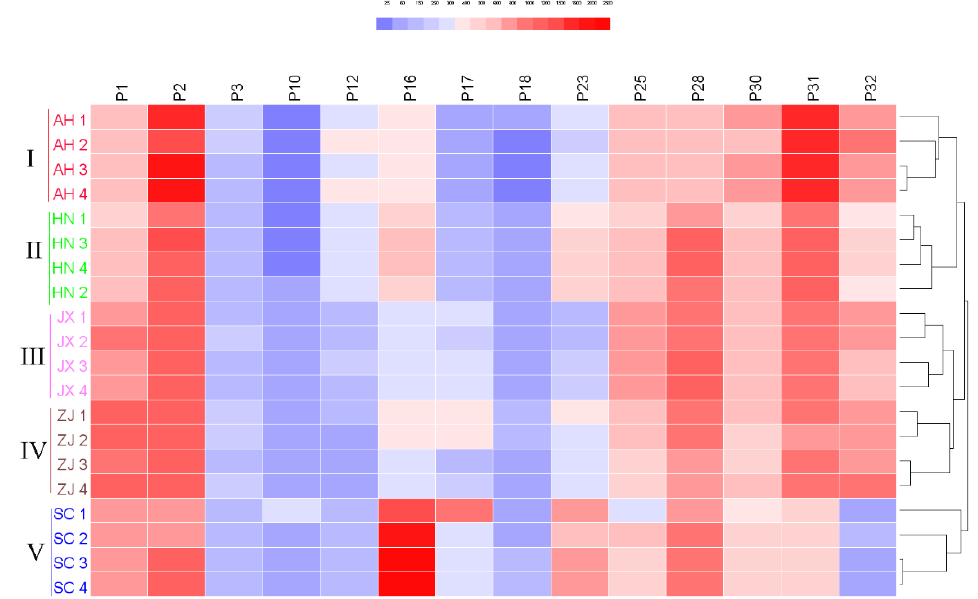
Figure 8. The HCH: hierarchical clustering heatmap of 20 batches of Chansu samples from five provinces based on peak areas data of fourteen characteristic compounds.